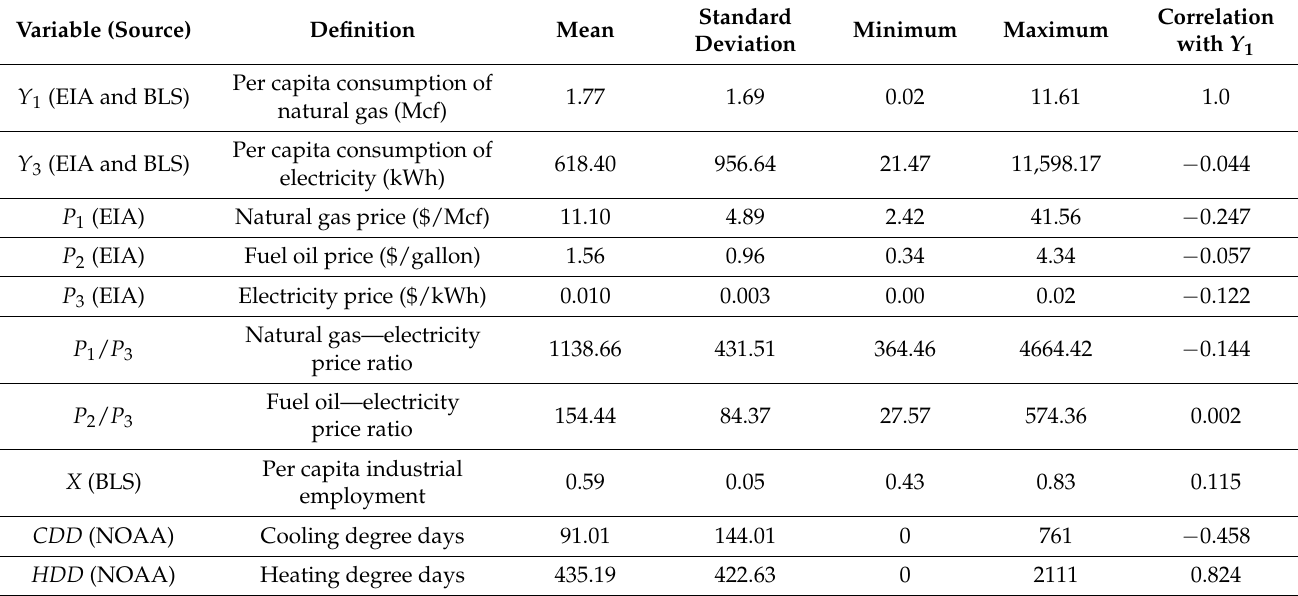
Table 2. Descriptive statistics for monthly data from Jan-1990 to Dec-2019 for the lower 48 states; number of observations =